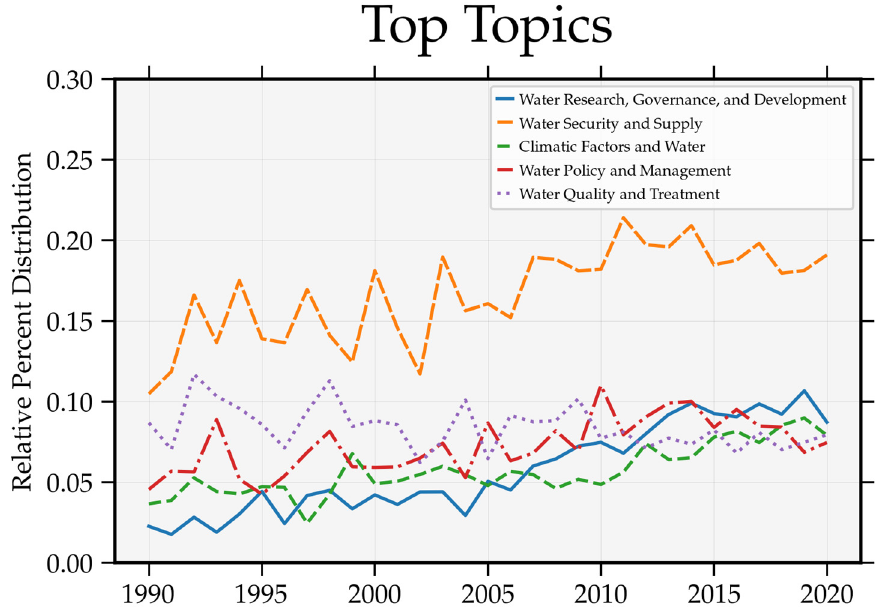
Figure 4. Top 5 topics—trends over time, 1990–2020.